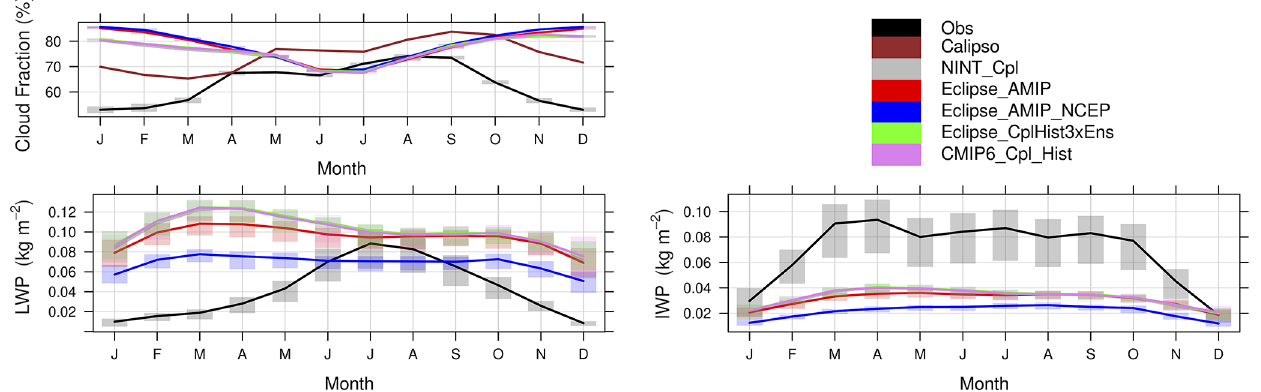
Figure 5. Observed and simulated Arctic climatological total cloud fraction (1995–2014 mean), liquid water path (2007–2014 mean), and ice water path (2007–2014 mean), along with the interannual variation shown in bars. Obs denote CLARA-A2 for the cloud fractions and CloudSat for the LWP and IWP.